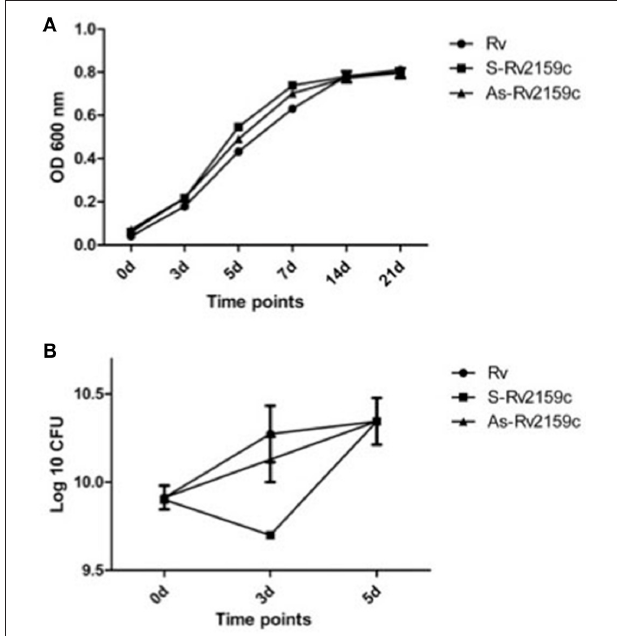
FIGURE 5 | In vitro growth kinetics of Rv2159c. (A) The S-Rv2159c and As-Rv2159c constructs in M. tuberculosis were grown in 7H9 supplemented medium and the growth kinetics were monitored at 0, 3, 5, 7, 14, and 21 d. Graph represents the OD 600 at different time points and represent by their mean ± SEM from three different experiments. Comparison of Rv vs. S-Rv2159c showed a significance of P < 0.001 at 5 and 7 d, comparison of Rv vs. As-Rv2159c showed a significance of P < 0.05 at day 5 and P < 0.01 at day 7. The statistical significance calculated by two way ANOVA using graph pad prism. (B) Survival kinetics of Rv2159c differentially expressing strains in M.tuberculosis . The S-Rv2159c and As-Rv2159c constructs in M. tuberculosis were plated in complete 7H10 agar plate and CFUs were measured at 0, 3, and 5 day and represent by their mean ± SEM from